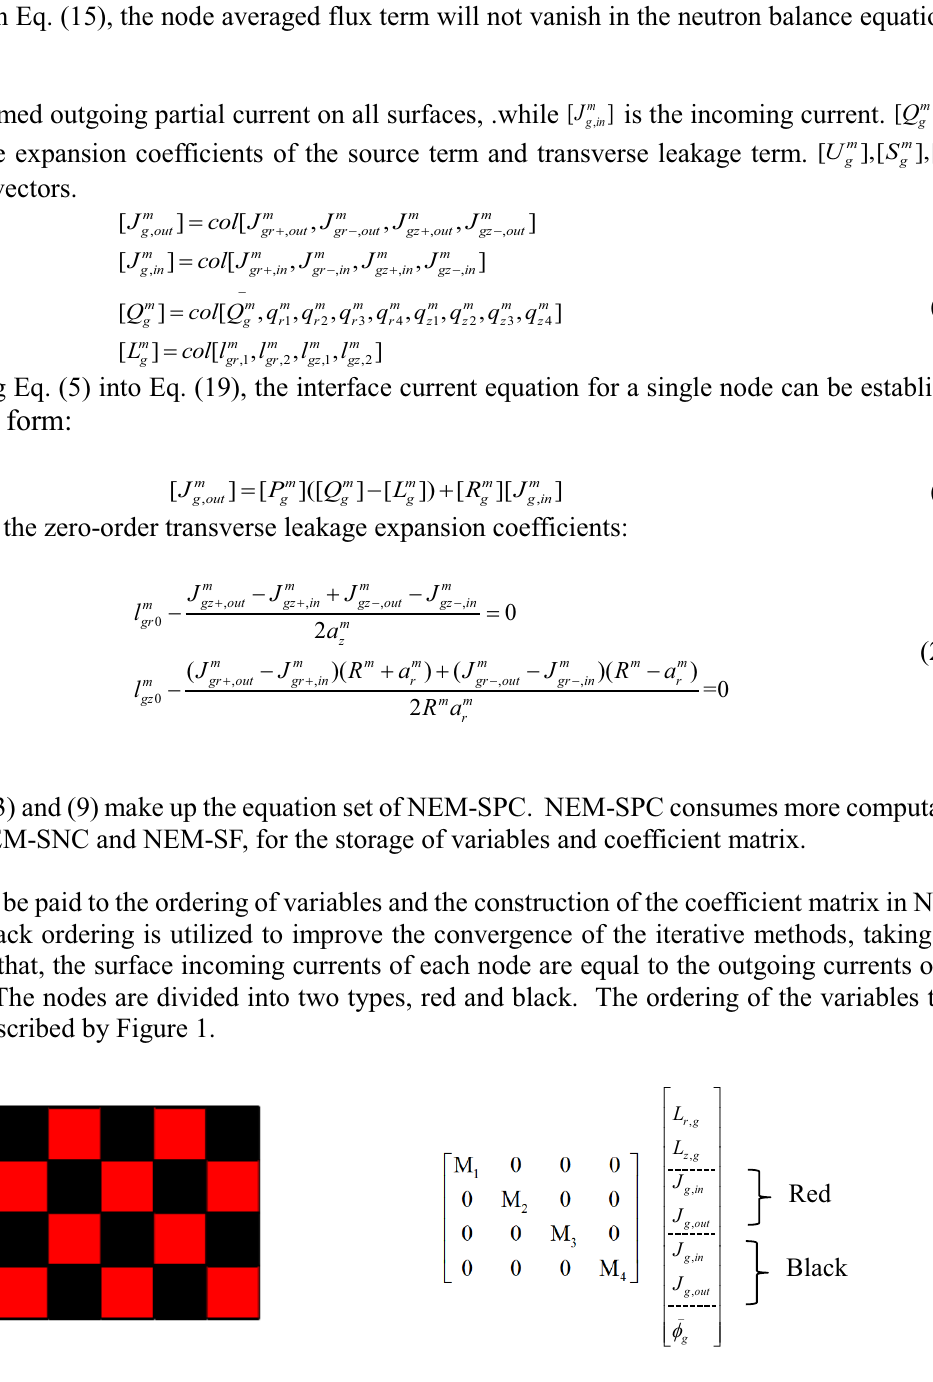
Figure 1. Red-black ordering in